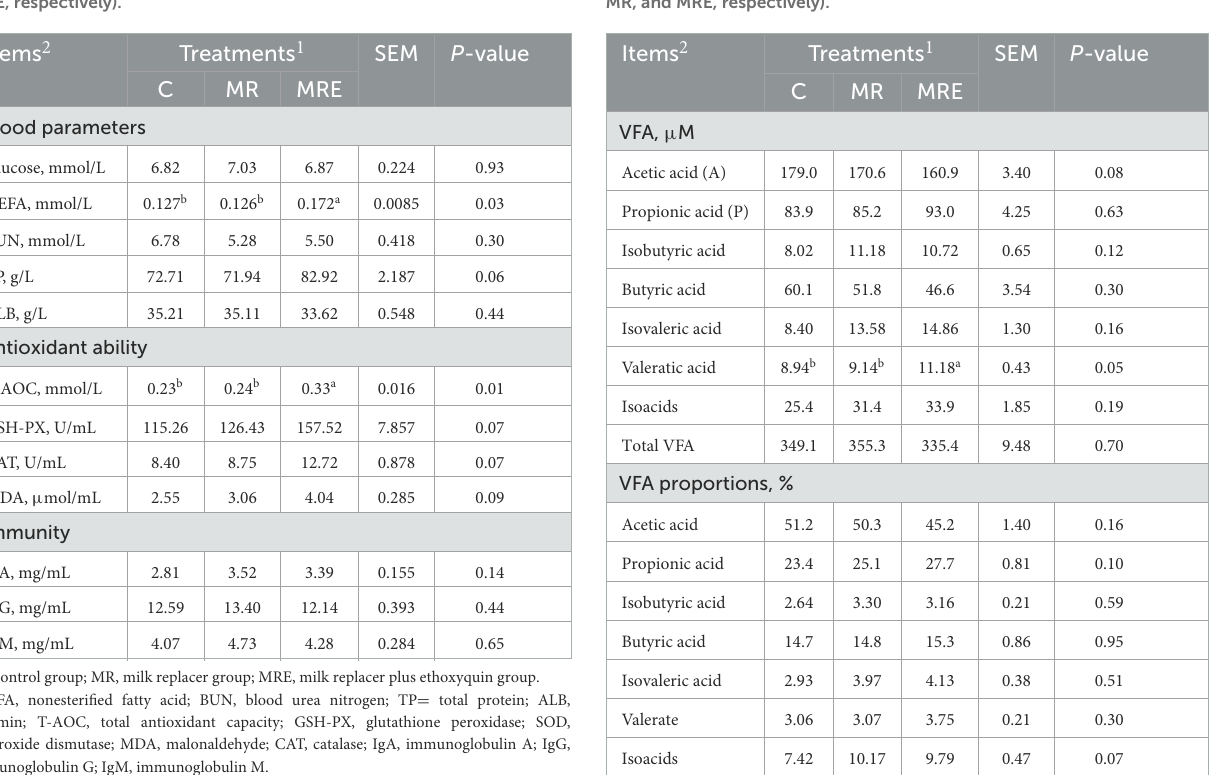
TABLE 5 Effects of milk, milk replacer and milk replacer plus ethoxyquin on fecal fermentation profiles of Holstein calves ( N = 11,9, and 11 in C, MR, and MRE,